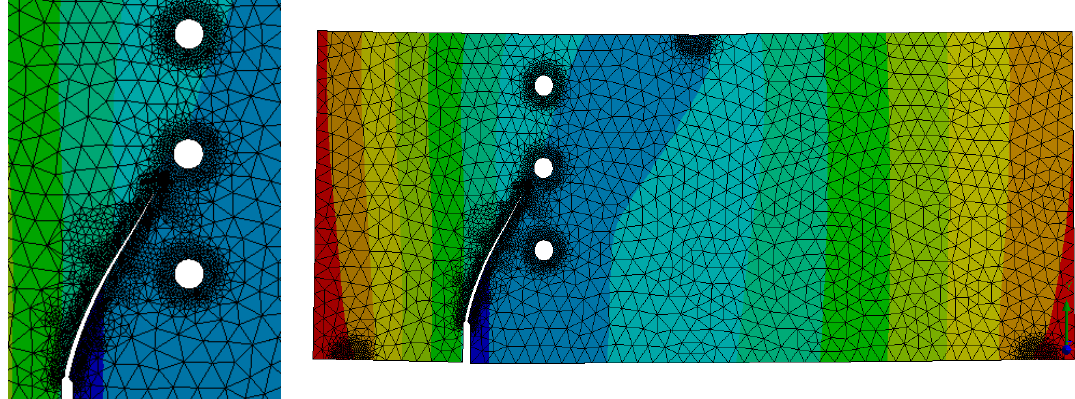
Figure 9. Final step of the crack growth trajectory for specimen 3.